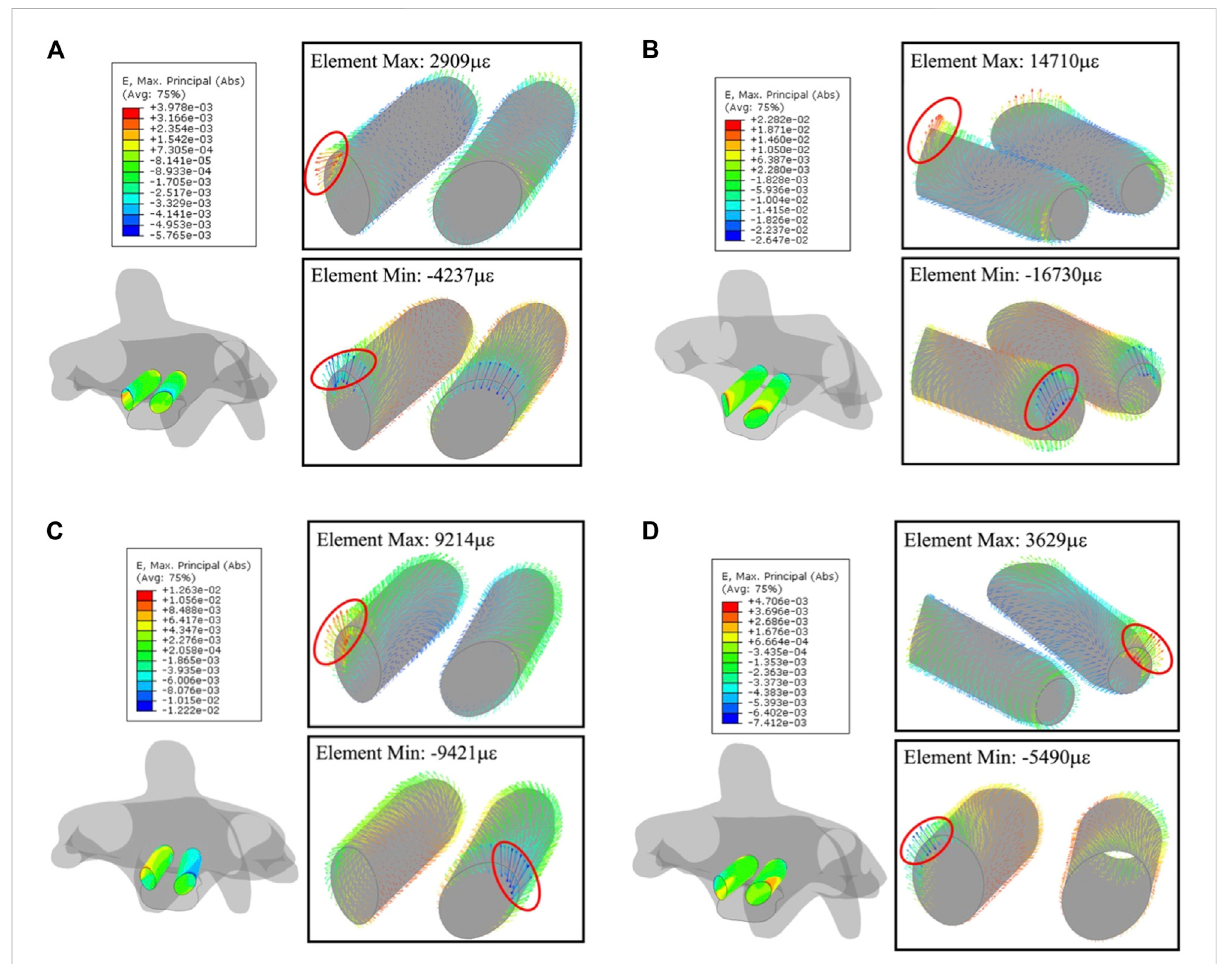
FIGURE 9 Principal-strain and deforming direction surrounding the trajectories in C2. (A) Flexion, (B) extension, (C) lateral fl exion, and (D) axial rotation. Left fi gure in each motion is the strain on nodes, fi gures within the box display the strain in each